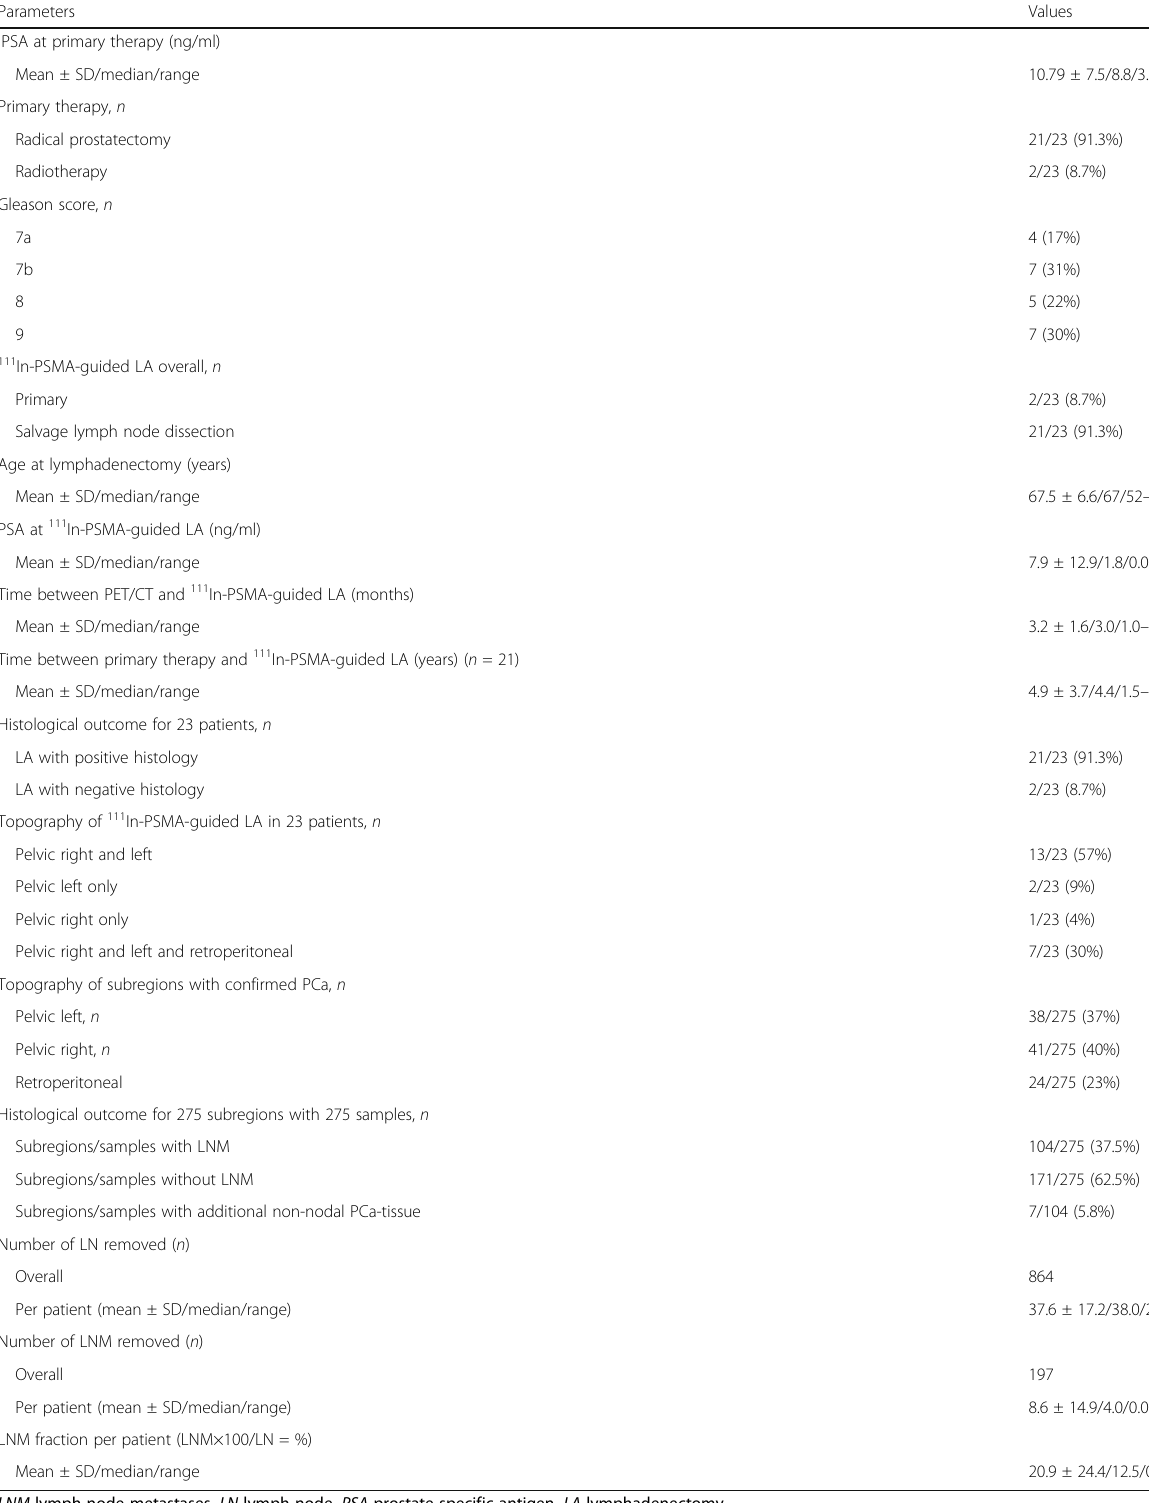
Table 1 Patient characteristics, history of prostate cancer and outcome from lymphadenectomies from 23 patients undergoing lymphadenectomy